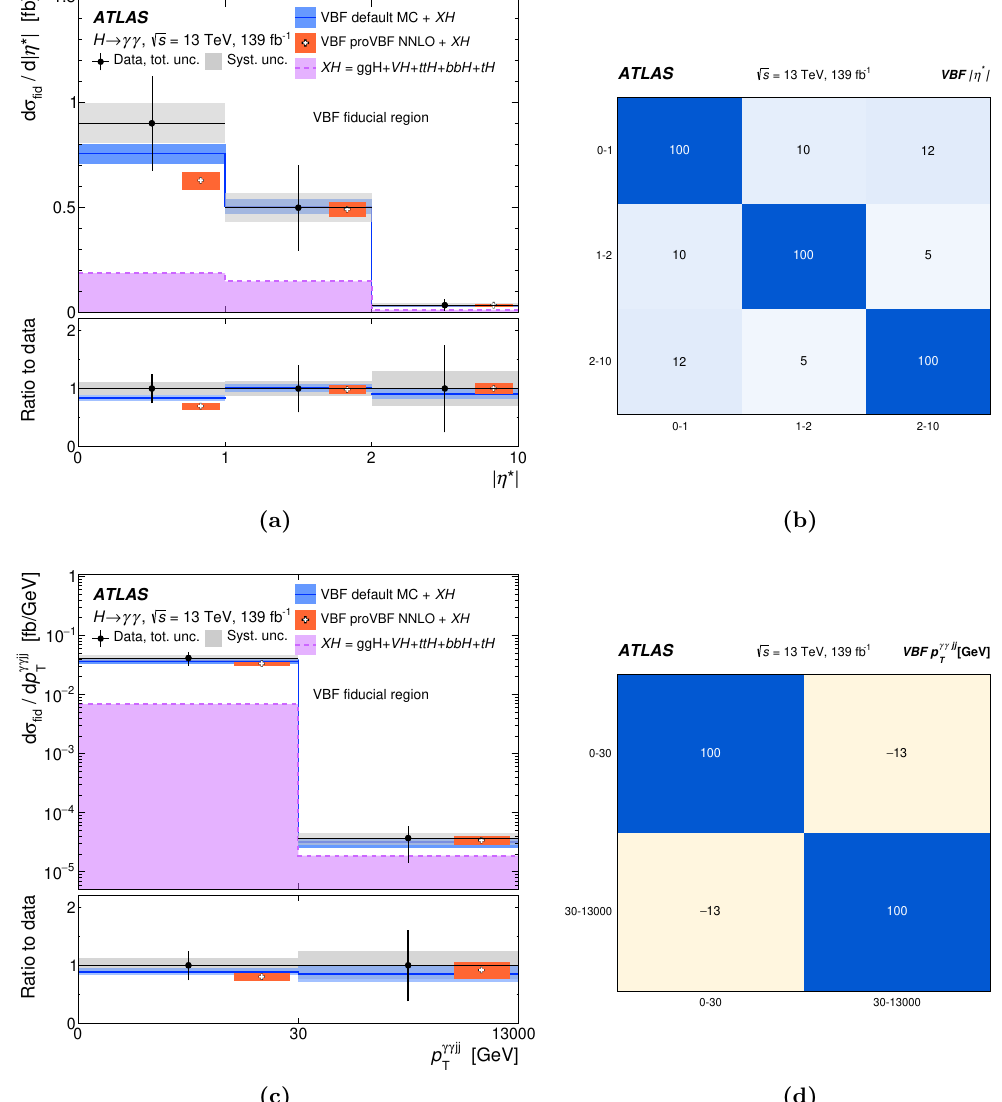
Figure 35. Particle-level fiducial differential cross-sections times branching ratio for the variables (a) | η ∗ | and (c) p together with the corresponding correlation matrices ((b) and (d)) in the T ,γγjj VBF-enhanced fiducial